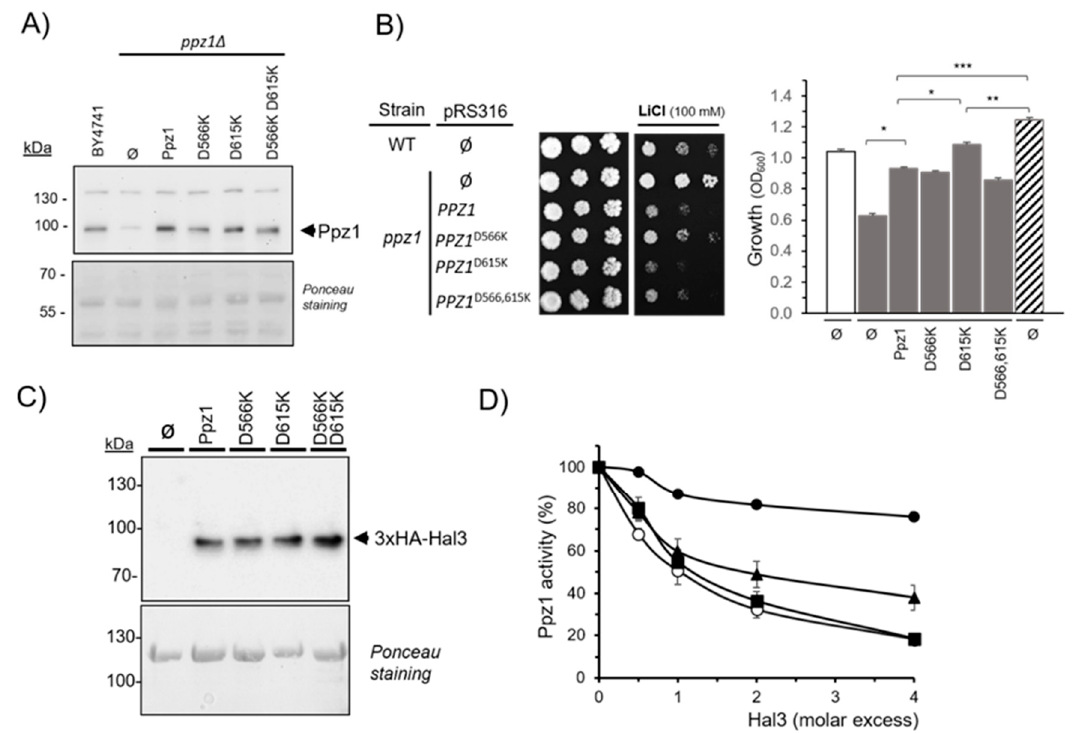
Figure 7. Functional characterization of the D566K and D615K mutations in Ppz1. ( A ) Forty mi- crograms of protein extracts from the wild-type strain BY4741 and ppz1 Δ cells bearing the different variants of Ppz1 (Ø, empty plasmid) were subjected to SDS-PAGE (10% polyacrylamide gels) and were transferred to membranes. The Ppz1 versions were detected with a polyclonal anti-GST-Ppz1 antibody. ( B ) Left panel. Wild-type and ppz1 Δ cells were transformed with the diverse versions of Ppz1 and cultures spotted (OD 660 = 0.05 and at 1/5 serial dilution) on synthetic media (lacking uracil) plates with or without 100 mM LiCl. Pictures were taken after six days. Ø, empty plasmid. Right panel. Strains JA100 (wild type, open bar), JC10 ( slt2 Δ , grey bars) and CCV186 ( slt2 Δ hal3 Δ , striped bars) were transformed with the indicated plasmids and growth in liquid culture in the presence of 2 mM caffeine (initial OD 600 = 0.004) as in [33]. Growth was monitored every 30 min in a BioScreen C apparatus (Thermo Fisher Sci., Waltham, MA, USA) and a representative result after 24 h is shown. Data are mean ± SEM from three independent clones determined at least by duplicate. *, p < 0.01; **, p < 0.001; ***, p < 0.0001 ( C ) Interaction of the different versions of Ppz1 with Hal3. Equal amounts of the indicated versions of GST-tagged phosphatases were immobilized on glutathione beads and incubated with protein extracts of strain IM021 ( ppz1 Δ hal3 Δ ) expressing a HA-tagged version of Hal3. Beads were washed and processed for SDS-PAGE (8% polyacrylamide gels) and immunoblotting using anti-HA antibodies as described in Materials and Methods. Ponceau staining shows the amount of GST-Ppz1 in the assay. ( D ) The different versions of Ppz1 ( ○ , native; ■ , D566K; • , D615K; ▲ , D566K D615K) were incubated with increasing amounts of bacterially expressed Hal3. Data are represented as the percentage of phosphatase activity in the absence of inhibitors and correspond to the mean ± SEM from at least three independent determinations using two different preparations of each